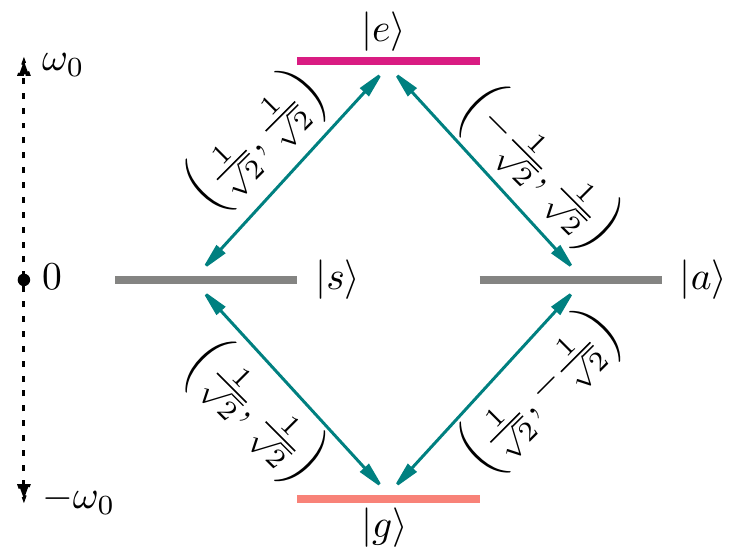
Figure 1 . The energy levels corresponding to the eigenstates of the collective two-level two-atom system is depicted in this diagram. This figure has been taken from [25]. The contributions from the monopole moment for each transition are also